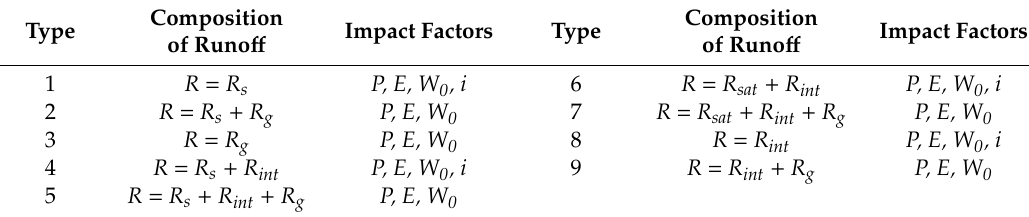
Table 2. Combination of basin runo ff generation